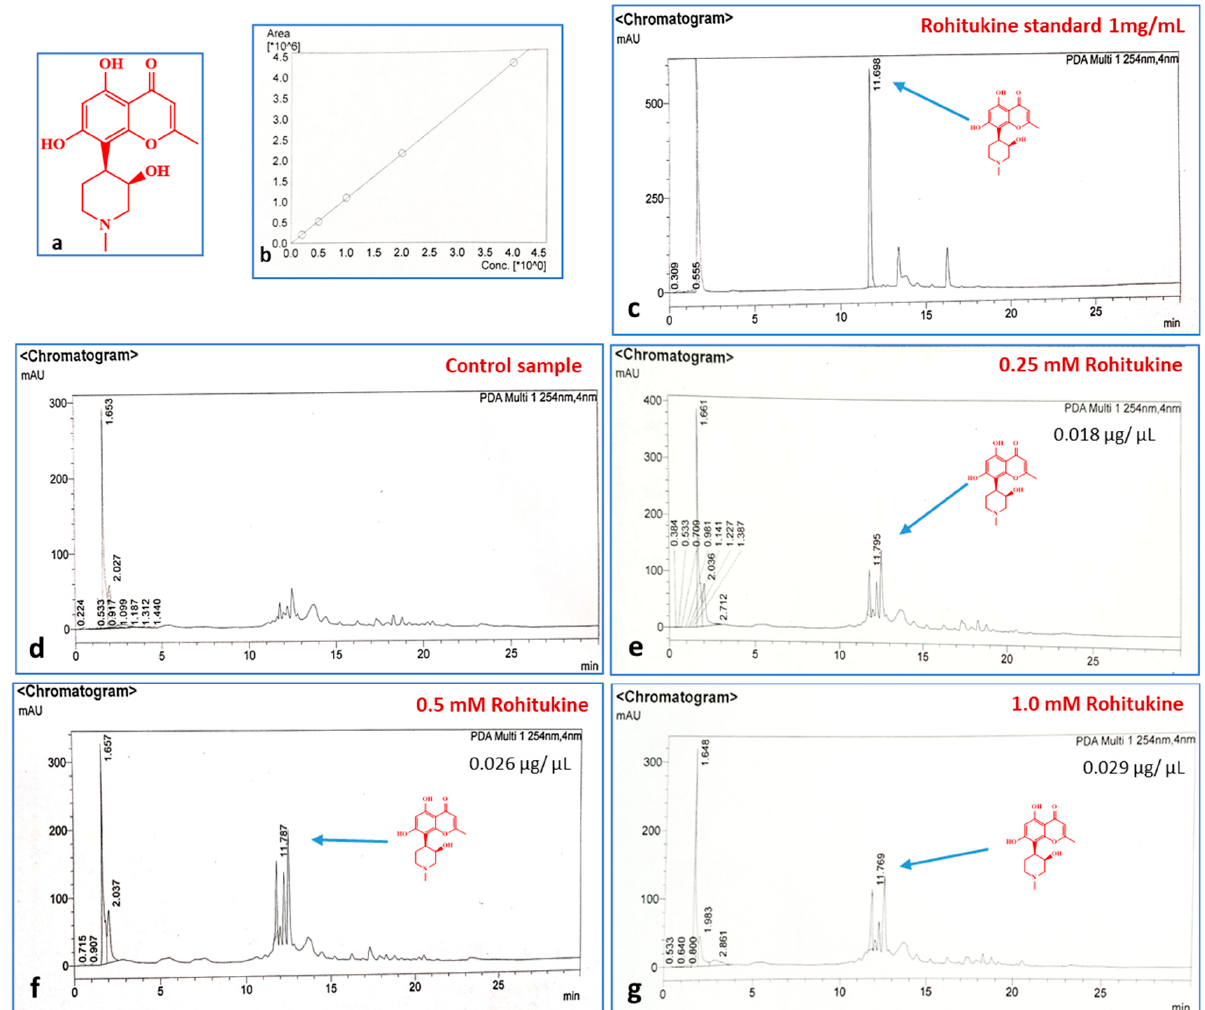
Figure 2. Detection and quantification of rohitukine in treated A. thaliana samples. ( a ) Structure of rohitukine. ( b ) Calibration curve of standard rohitukine. ( c ) Rohitukine standard, 1 mg/mL. ( d ) A. thaliana control peaks showing no traces of rohitukine. ( e – g ) Peaks indicating the presence of rohitukine at 0.25 mM, 0.5 mM and 1.0 mM